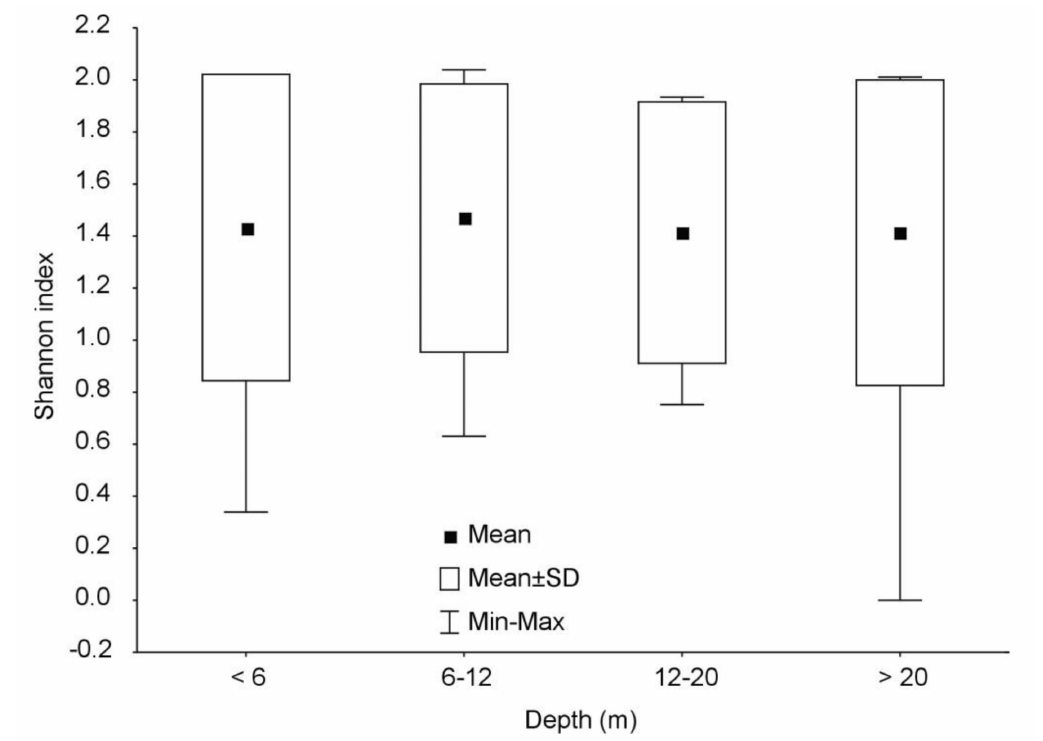
Figure 4. The Shannon index in 535 Polish lakes of different maximum depth. SD = standard deviations.